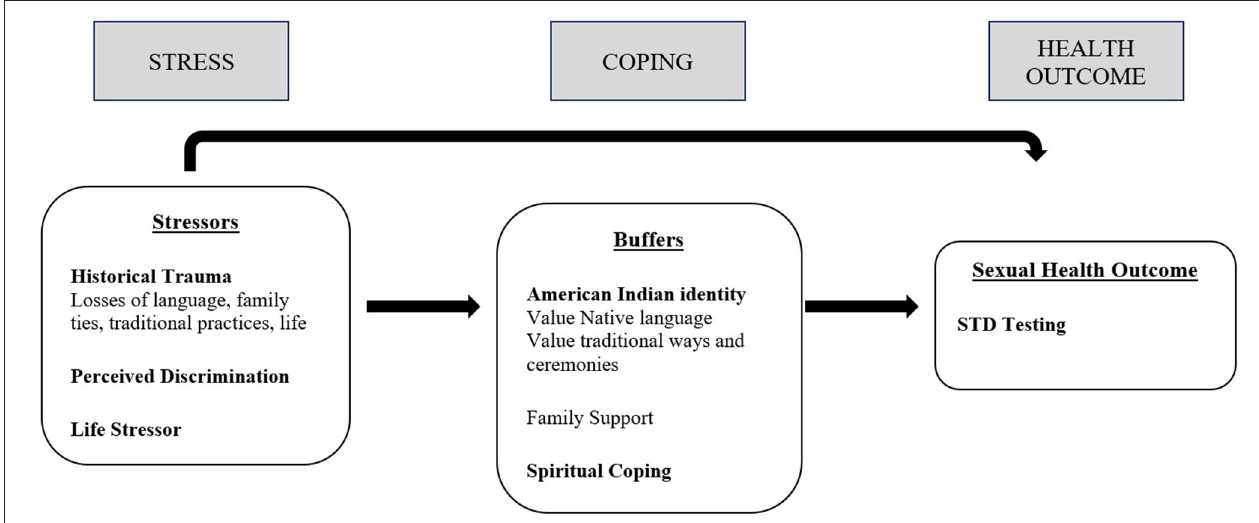
FIGURE 1 | Modeling indigenist stress-coping model predicting STD testing. Adapted from Walters and Simoni (31) and Walters et al. (5, 44,